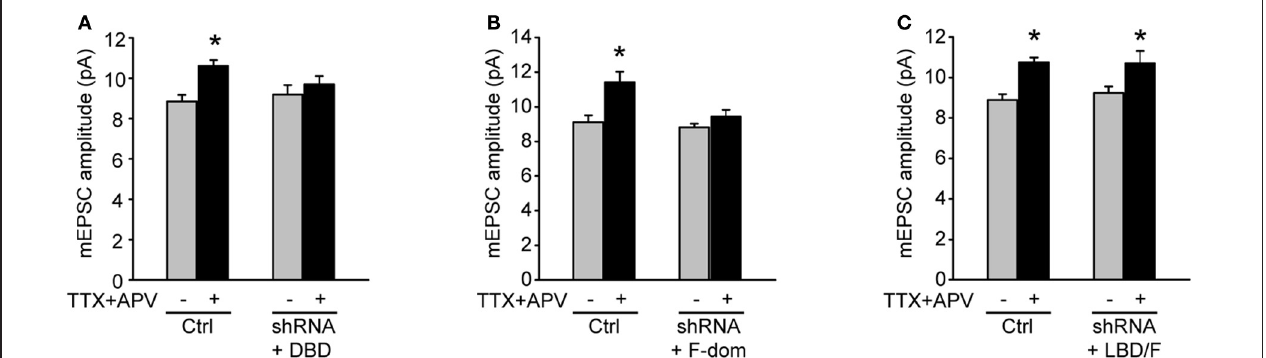
8 . 85 ± 0 . 32pA; ctrl/TTX + APV: 10 . 60 ± 0 . 29pA; shRNA + DBD/no treatment: 9 . 20 ± 0 . 47pA; shRNA + DBD/TTX + APV: 9 . 70 ± 0 . 40pA. B : ctrl/no treatment: 9 . 11 ± 0 . 40pA; ctrl/TTX + APV: 11 . 40 ± 0 . 61pA; shRNA + F/no treatment: 8 . 80 ± 0 . 22pA; shRNA + F/TTX + APV: 9 . 43 ± 0 . 40pA. C : ctrl/no treatment: 8 . 90 ± 0 . 28pA; ctrl/TTX + APV: 10 . 75 ± 0 . 25pA; shRNA + LBD-F/no treatment: 9 . 24 ± 0 . 32pA; shRNA + LBD-F/TTX + APV: 10 . 70 ± 0 . 62pA. n = 9–12, from two independent experiments; ∗ p < 0 .